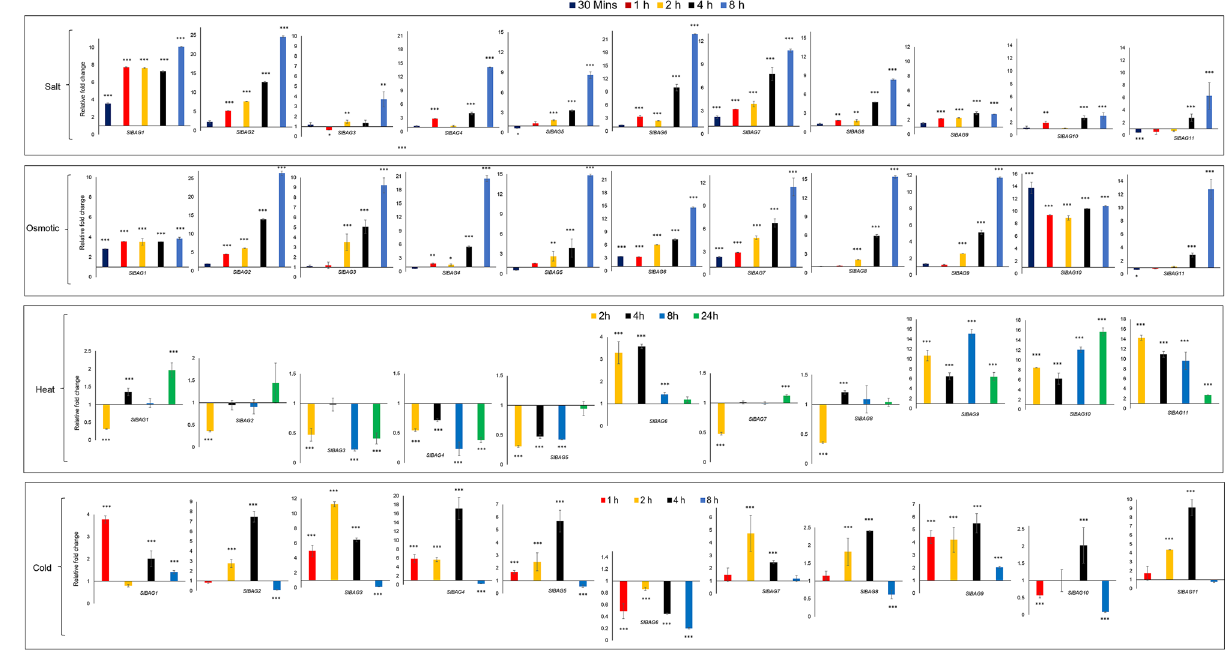
Figure 4. qRT-PCR based expression profiling of SlBAGs during abiotic stress conditions. Transcript accumulation in 15-day-old tomato seedlings exposed to 200 mM NaCl for salt stress, 250 mM mannitol for osmotic stress, heat and cold was measured by qRT-PCR using tomato actin as endogenous control by considering reference expression level 1 at 0 h time point using 2 −ΔΔCT method. All data are presented as the mean (± SE) of three independent biological determinations and analysed using Student’s t-test (*p < 0.05, **p < 0.01, ***p <